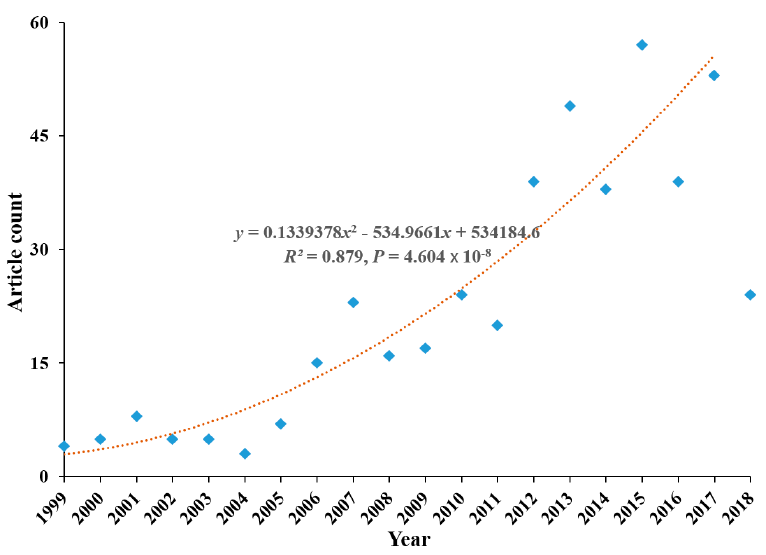
Figure 1. Analysis of trends in articles.